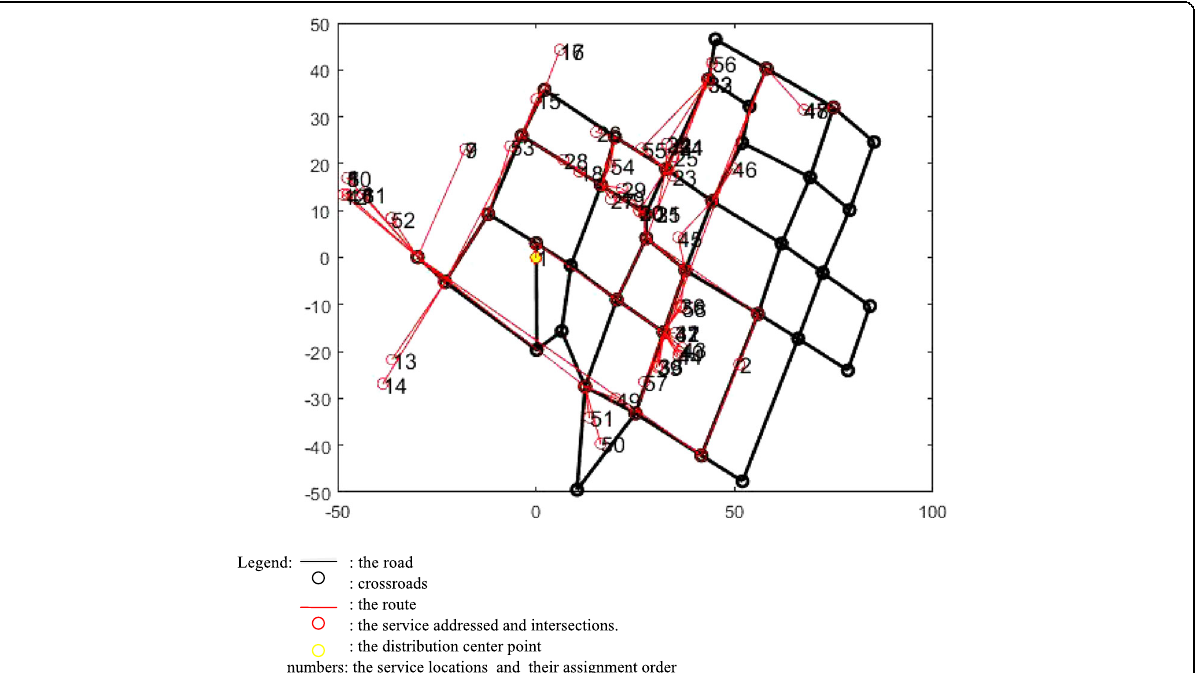
Fig. 2 Planning route 1. Black line represents the road, black circle represents the crossroads, red line represents the route, red circle represents the areas the service addressed and intersections, yellow circle represents the distribution center point, and numbers represent the service locations and their assignment order